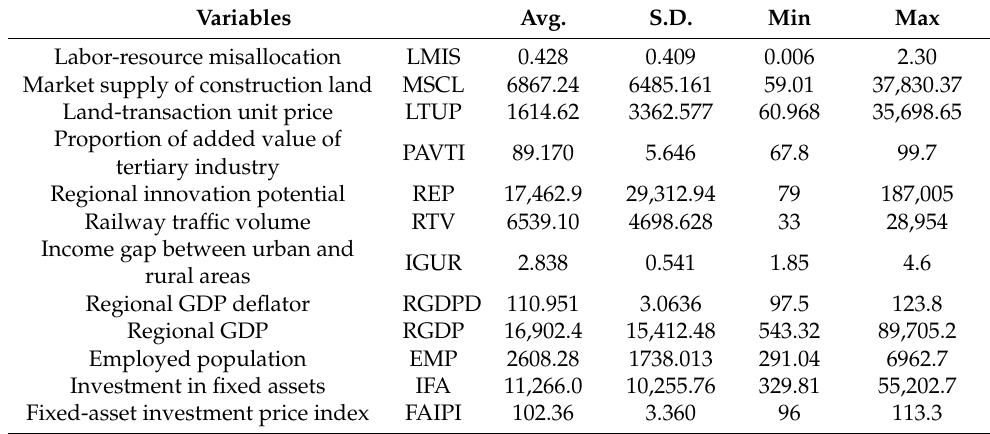
Table 1. Descriptive statistics of